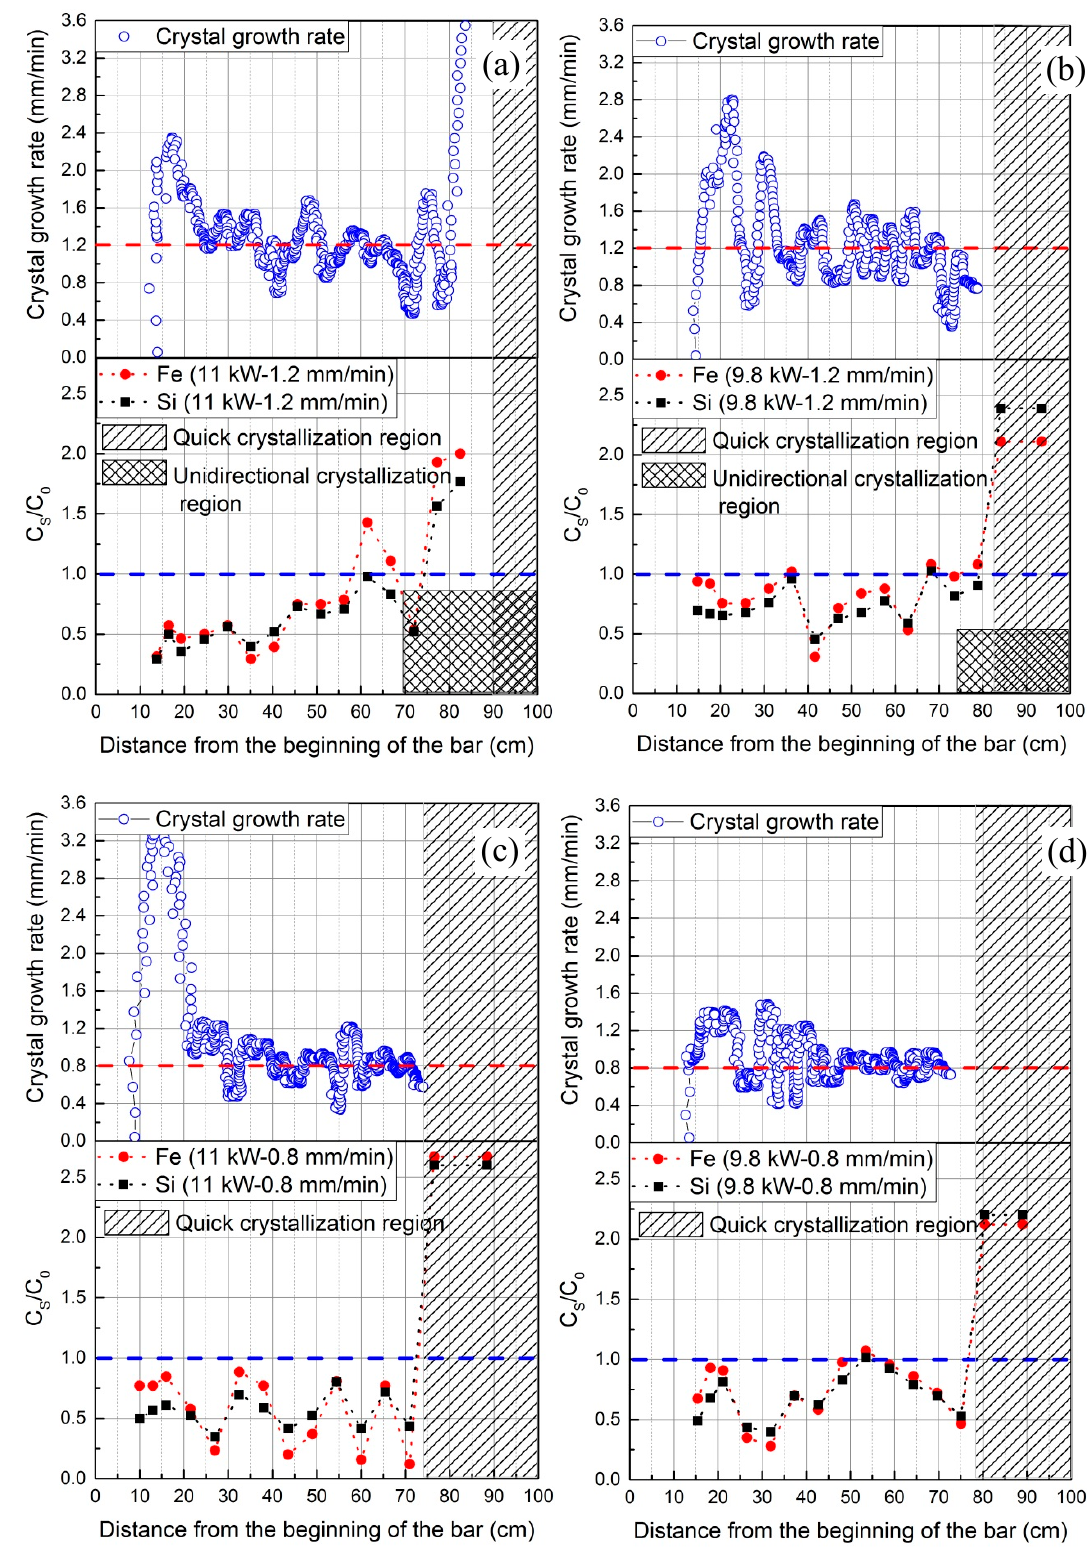
Figure 11. Comparison between the concentration distribution profile of impurities and the crystal growth rate for different experiments: ( a ) 11 kW-1.2 mm/min; ( b ) 9.8 kW-1.2 mm/min; ( c ) 11 kW-0.8 mm/min; ( d ) 9.8 kW-0.8 mm/min.